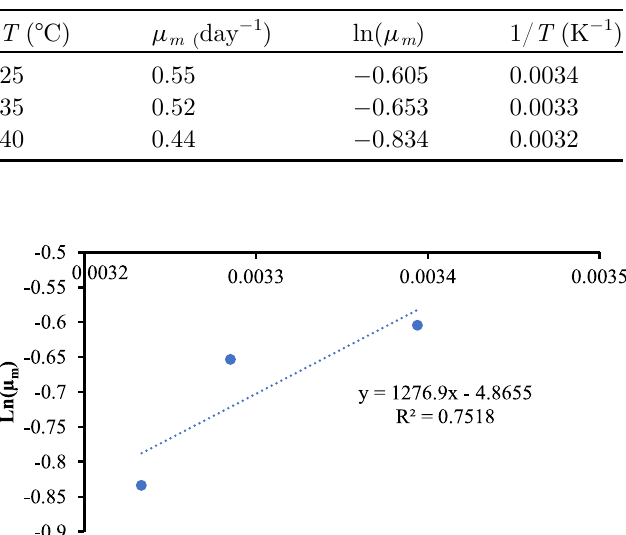
Table 1. Data used to fi t the Arrhenius model.